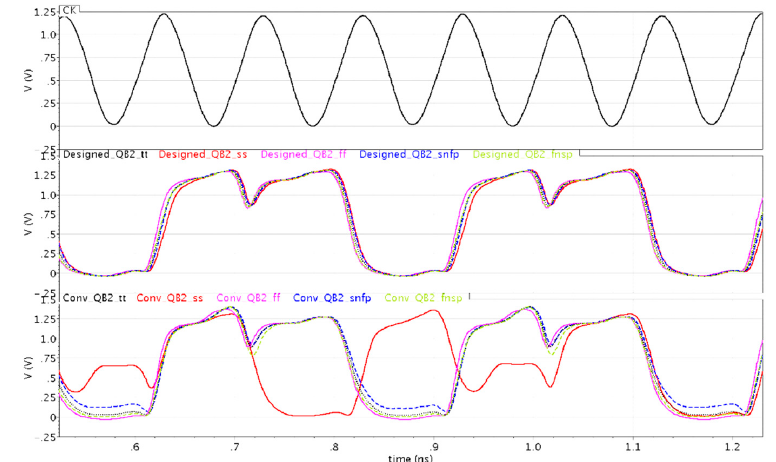
Figure 4. Corner simulation waveform of node Q B2 under divide-by-3 (Best case: ff, 1.1VDD, − 45 °C; Traditional case: tt, VDD, 50 °C; Worst case: ss, 0.9VDD, 125 °C.).